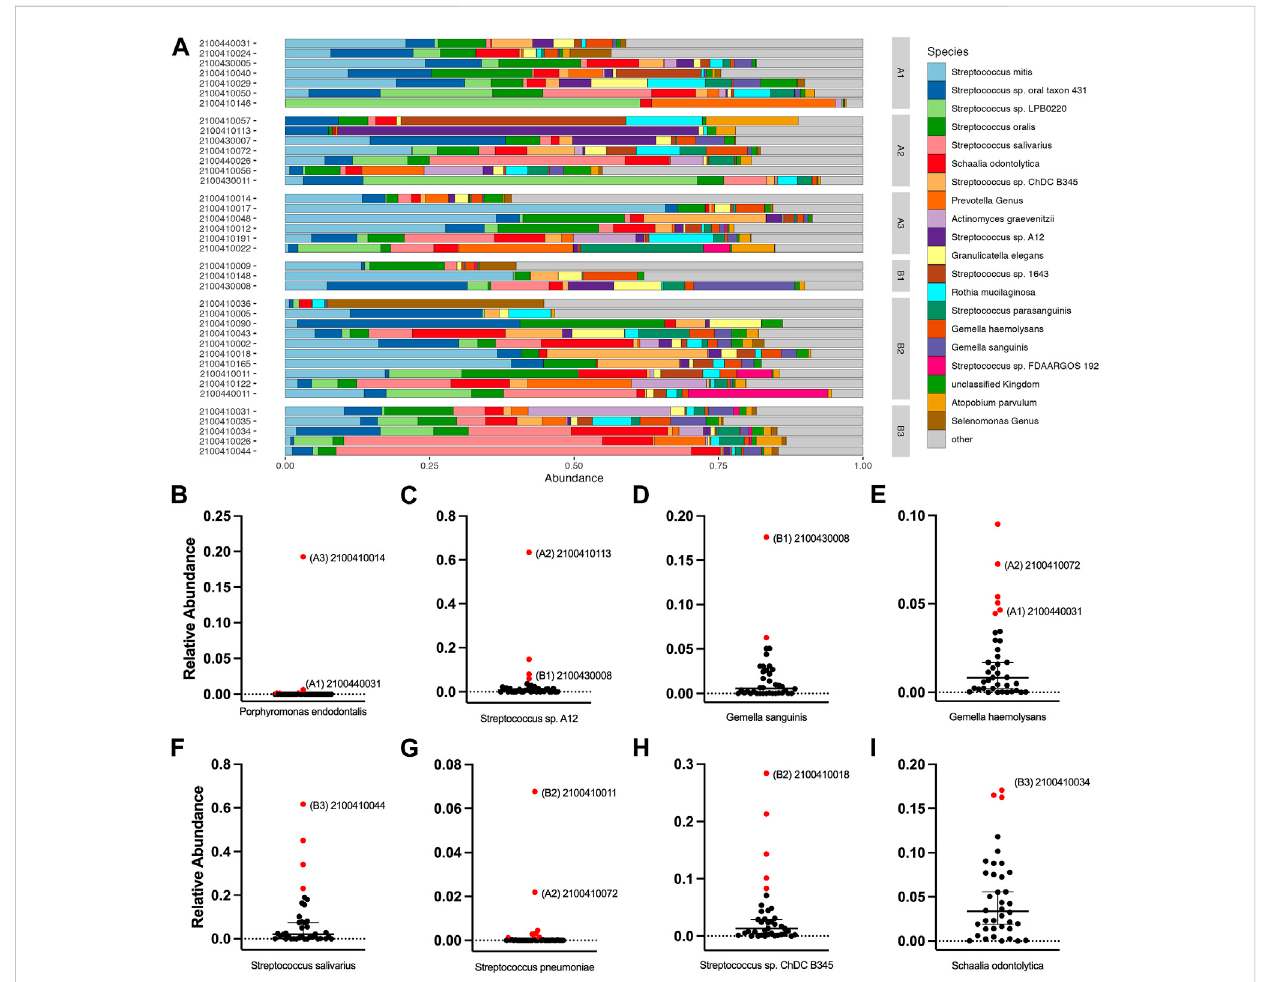
FIGURE 6 Salivary microbiome of samples analyzed using GCFP. From saliva samples analyzed by GCFP using the fi rst generation GCFP biosensor chip, 34 samples were also analyzed by 16S RNA high throughput sequencing. Relative abundance at species level was calculated. (A) Relative abundance of the top 20 most abundant taxa across all samples. (B – I) Plots of the relative abundance for 8 bacterial species that were elevated in one or more outlier samples from analyte data. Error bars represent a 95% con fi dence interval of the median. Points in red were identi fi ed as outliers by the ROUT method. Samples that were analyte outliers and had an increase in that species are labeled with their